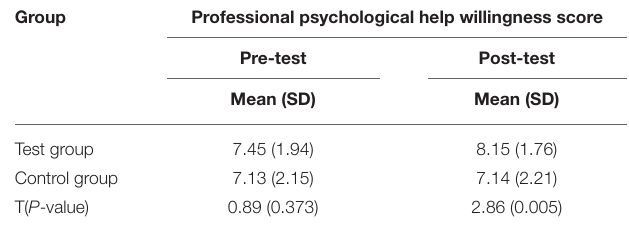
TABLE 5 | Sample test results of professional psychological willingness to ask for help.